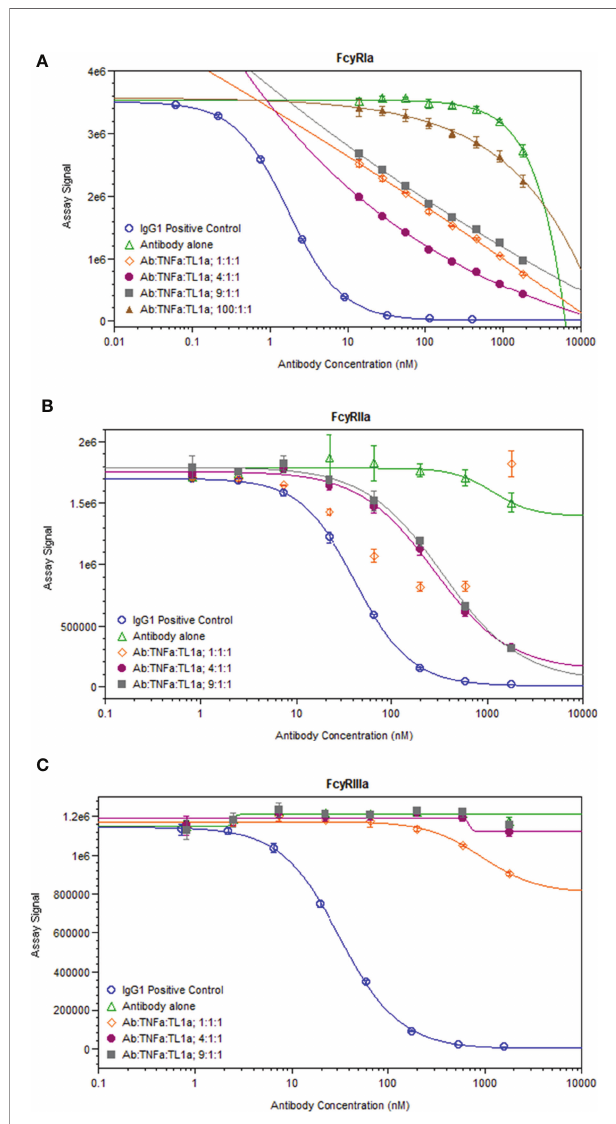
FIGURE 6 | AMG 966 complex formation with targets restored binding to Fc g RIa and Fc g RIIa. Competitive binding assays were utilized to assess the impact of AMG 966 complex formation with targets on Fc g R binding. An IgG1 positive control antibody was used in each assay and compared to AMG 966 alone and various ratios of AMG 966/target complex for ability to bind Fc g RIa (A) , Fc g RIIa (B) , or Fc g RIIIa (C)